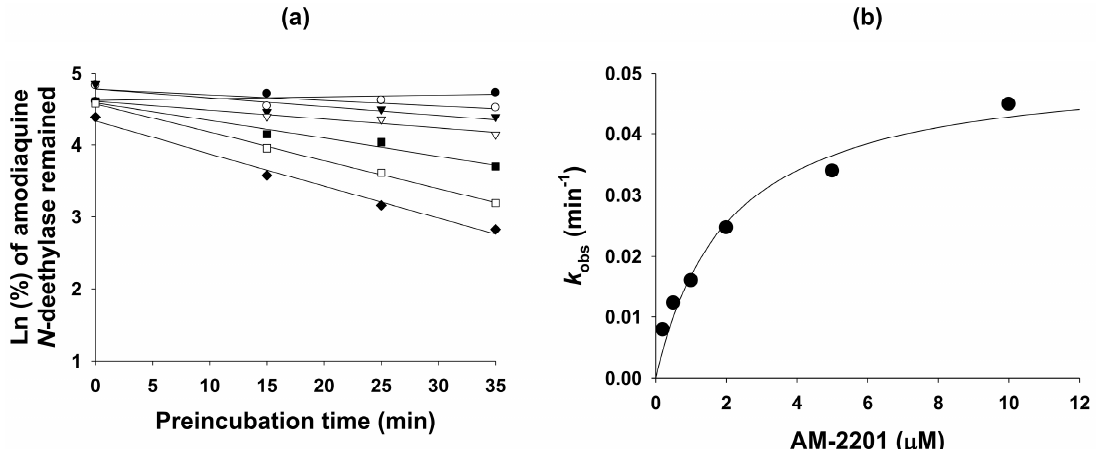
Figure 3. ( a ) Inactivation kinetics of the formation of N -deethylamodiaquine from amodiaquine in human liver microsomes by the following AM-2201 concentrations: , 0 μ M; , 0.2 μ M; , 0.5 μ M; , 1 μ M; , 2 μ M; , 5 μ M; , 10 μ M and ( b ) the relationship between k obs and AM-2201 concentrations to estimate k inact and K i values of CYP2C8-mediated amodiaquine N -deethylation. Data were derived from two replicates.